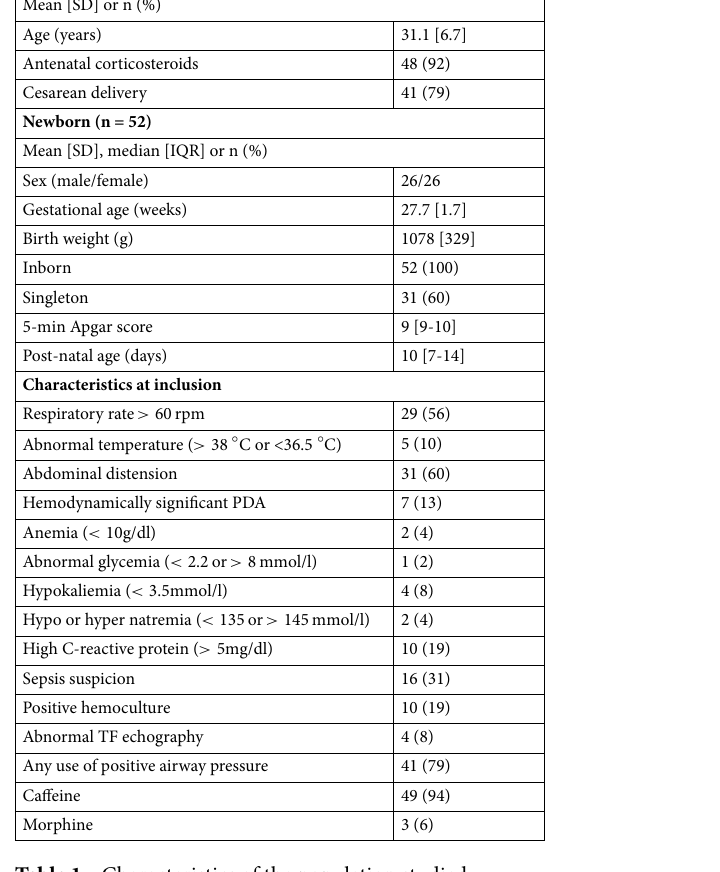
Table 1. Characteristics of the population